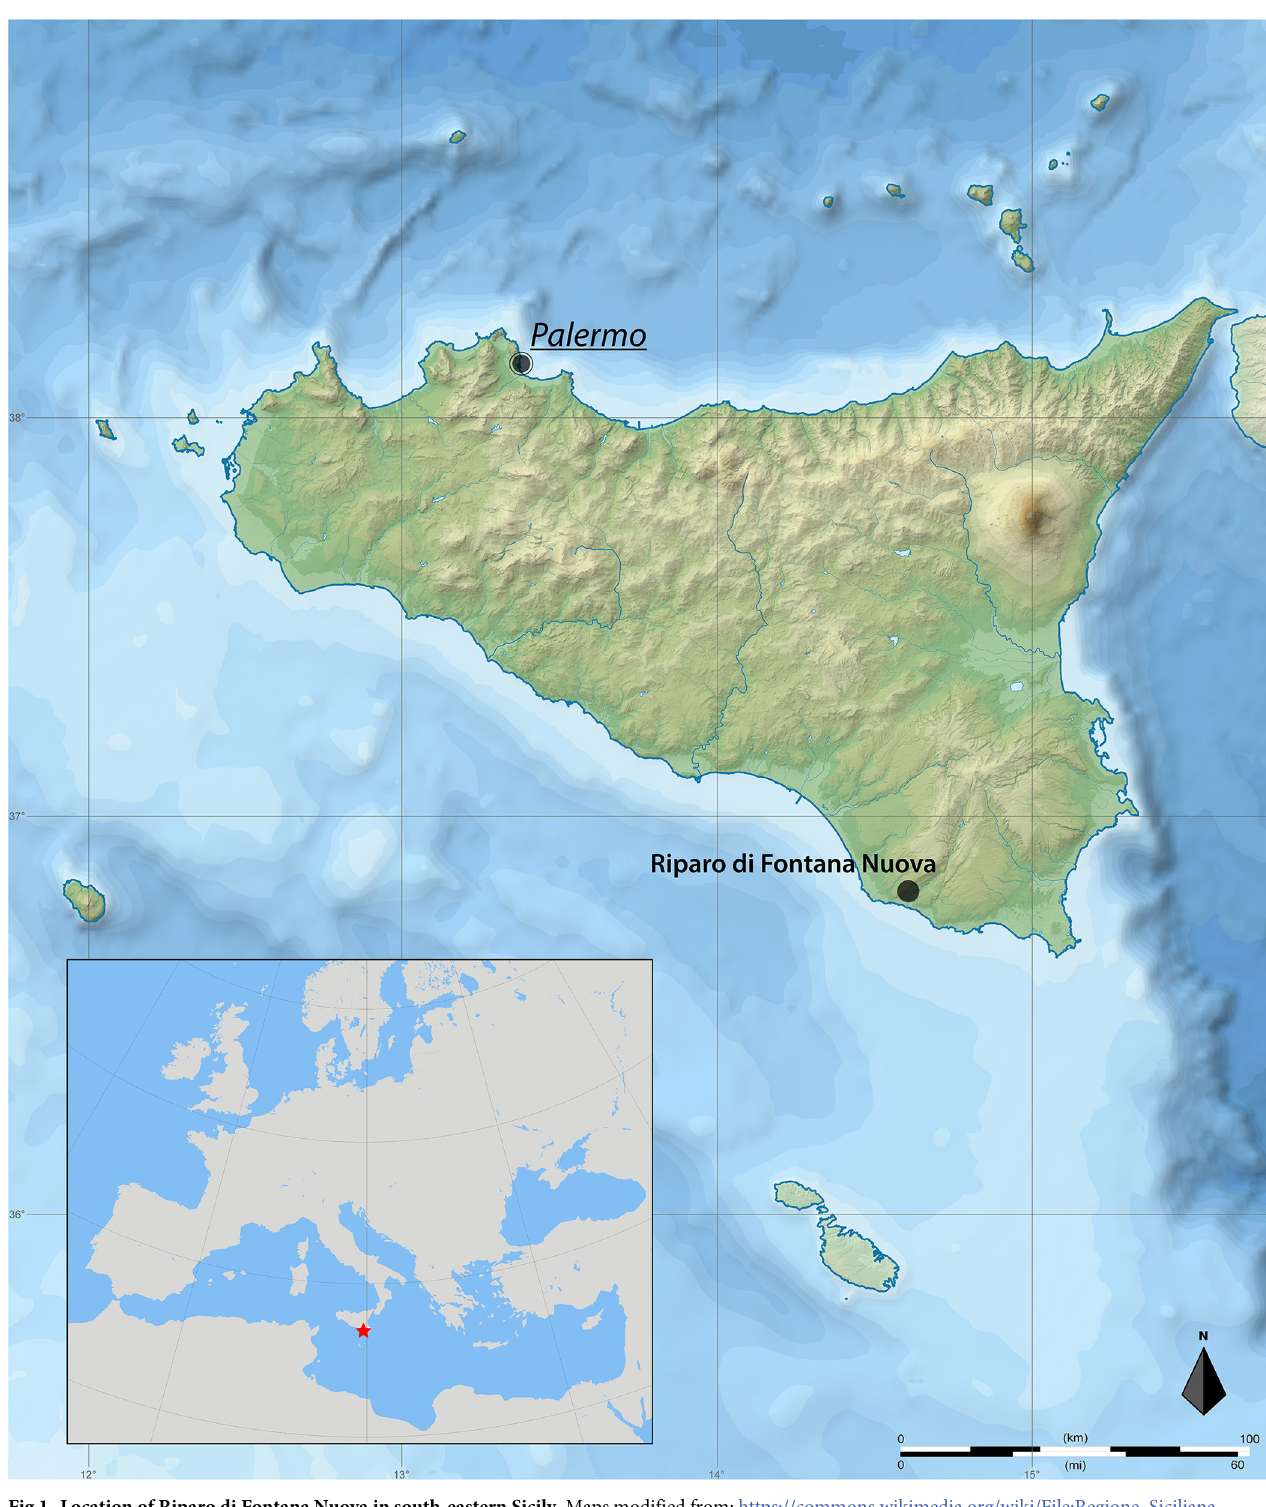
Fig 1. Location of Riparo di Fontana Nuova in south-eastern Sicily. Maps modified from: https://commons.wikimedia.org/wiki/File:Regione_Siciliana_ topographic_map-blank.svg# and https://commons.wikimedia.org/wiki/File:Blank_map_of_Europe_(polar_stereographic_projection)_cropped.svg.